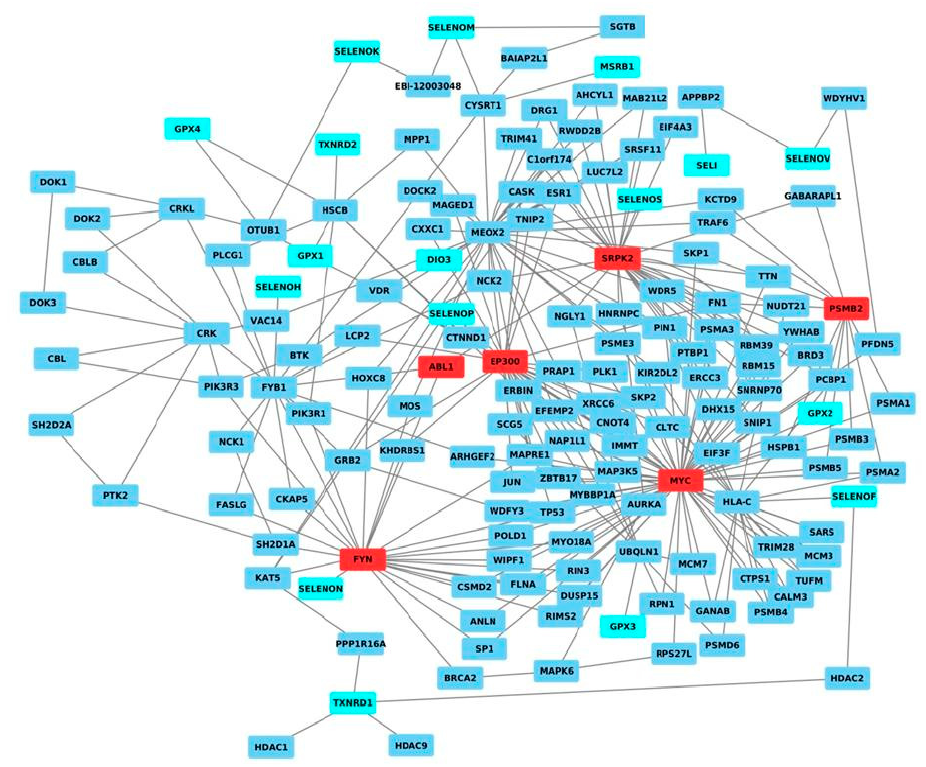
Figure 1. Network of the selenoproteins mapped on the human interactome. In detail, the selenoproteins are shown in cyan, HUB nodes are shown in red, whereas the other nodes are shown in blue.